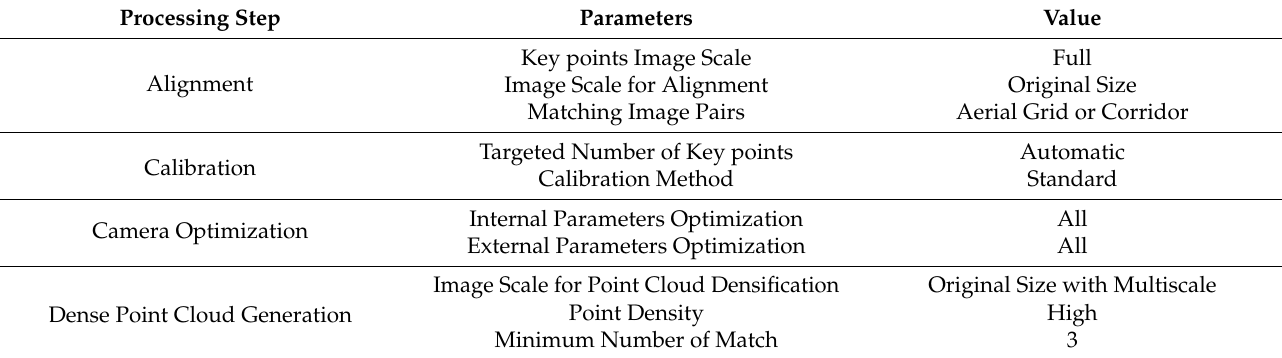
Table 3. Pix4DMapper Setting